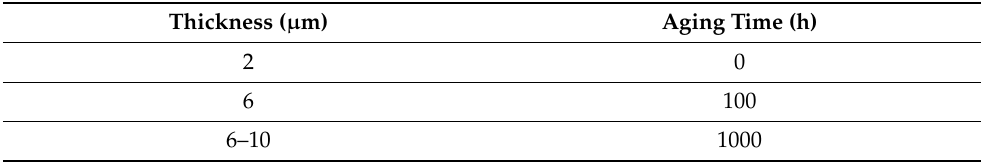
Table 2. IMC thickness at various thermal aging